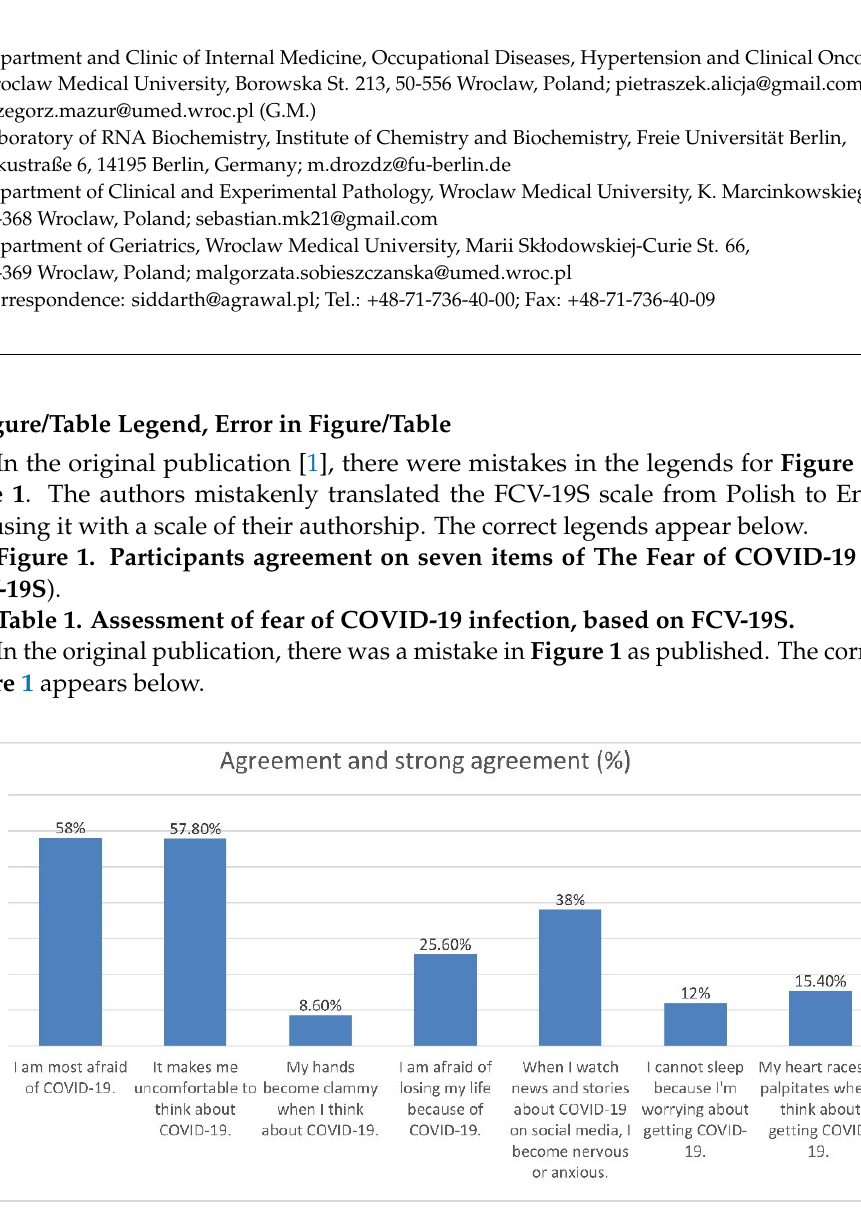
Figure 1. Participants agreement on seven items of The Fear of COVID-19 Scale (FCV-19S).